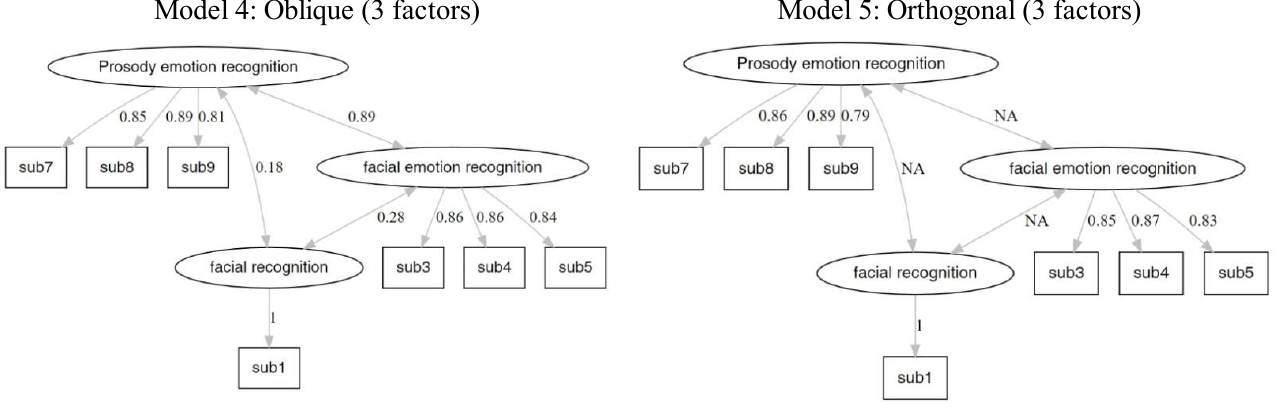
Figure 4. Model 4 and 5 are three-factor (facial recognition, prosody emotion recognition, and facial emotion recognition) models with oblique and orthogonal rotation, respectively.